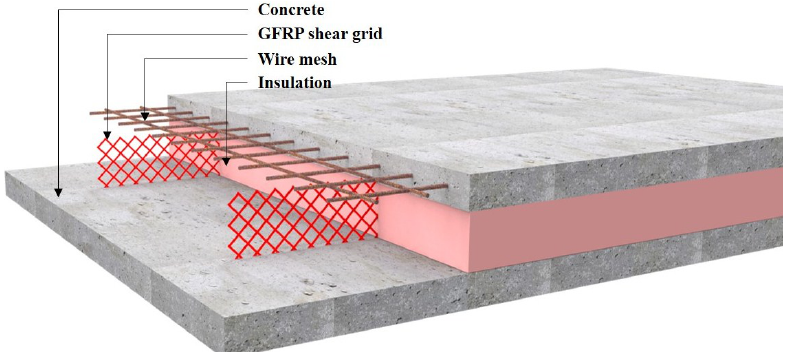
Figure 1. Insulated concrete sandwich wall panel reinforced with glass-fiber-reinforced polymer (GFRP) shear